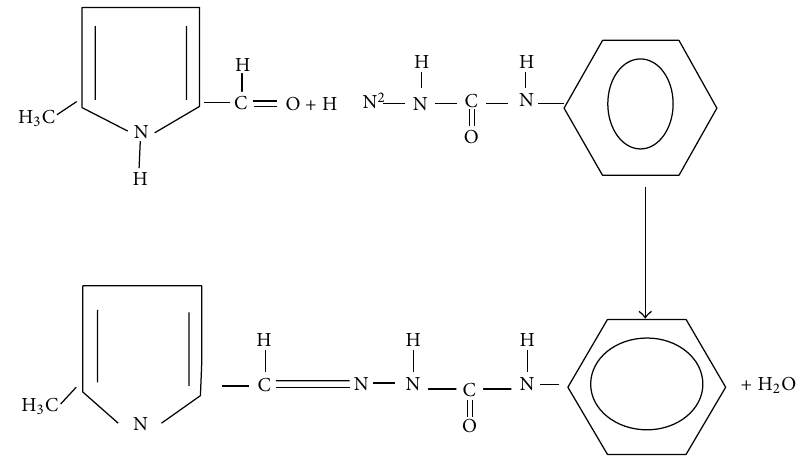
F 1: 2-Pyrrolecarboxaldehyde-4-phenylsemicarbazone.